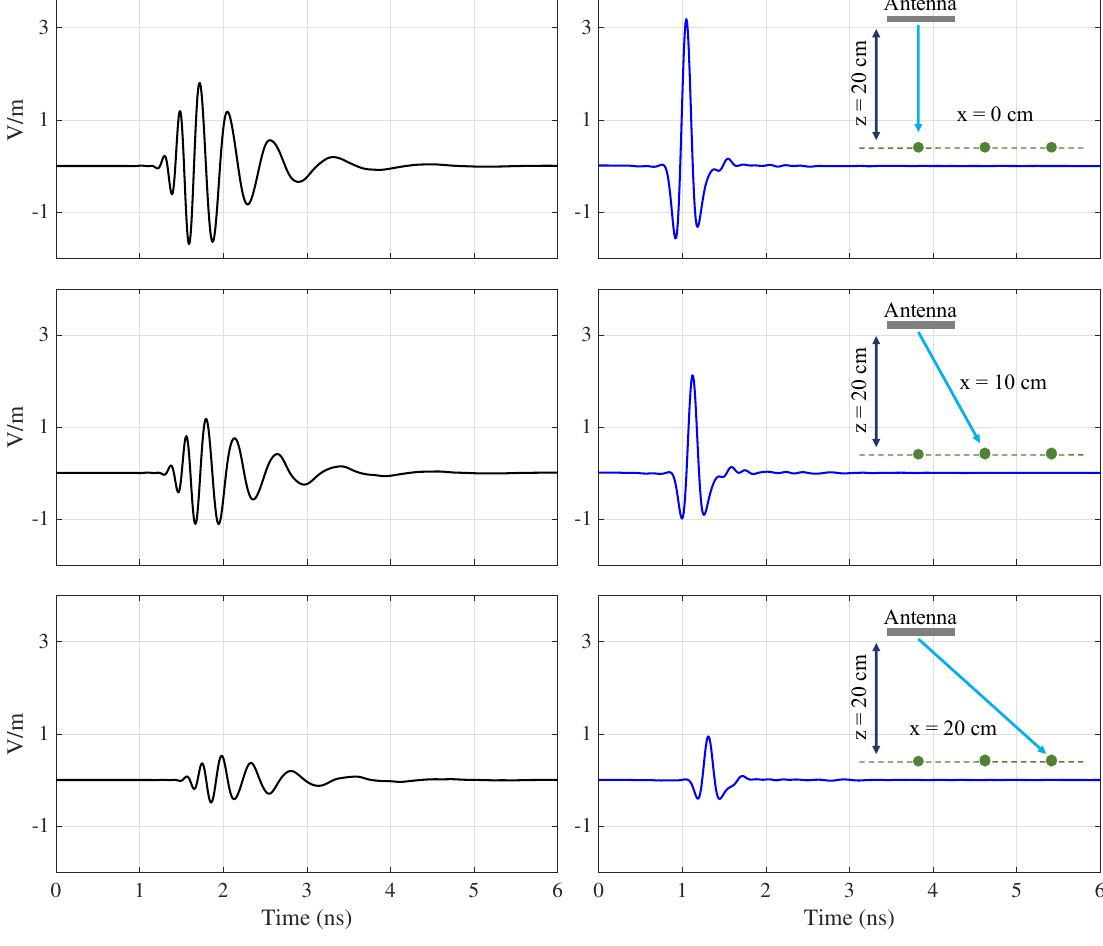
Figure 9. Radiated pulses from the 16-cell antenna at 20 cm boresight depth and three perpendicular scan locations: 0, 10, 20 cm. The pulses are shown both before ( left ) and after ( right ) application of the optimized simple antenna dispersion model listed in Table